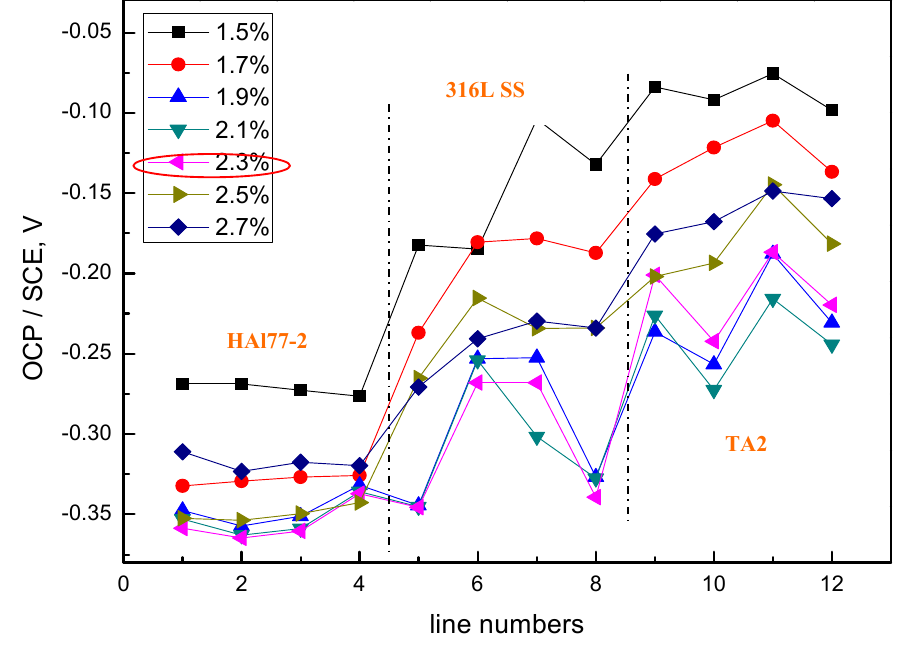
Figure 4. Average potential values of each microelectrode line for CMEA1 at the OCP after immersion in artificial seawater with different concentrations of chloride ions (wt %).